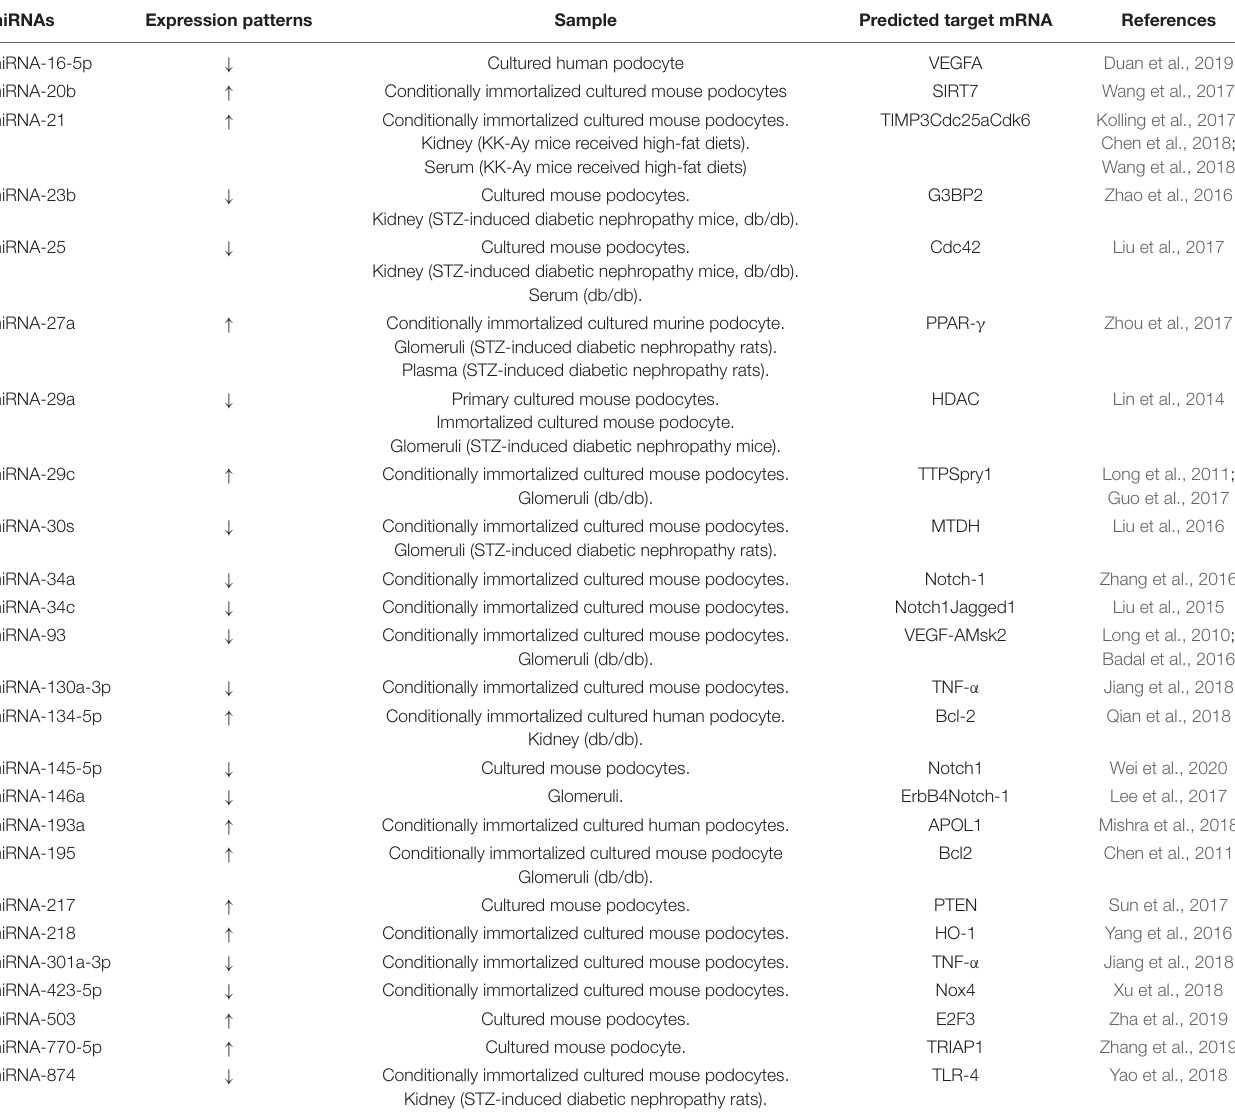
TABLE 1 | Associations between podocyte injury and miRNA expression levels in cultured podocyte cells and rodent models of diabetic nephropathy.